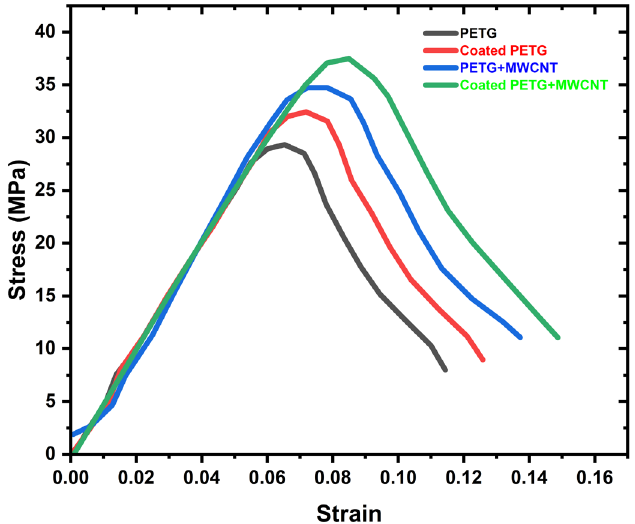
Figure 7. Stress–strain curve for various specimens.